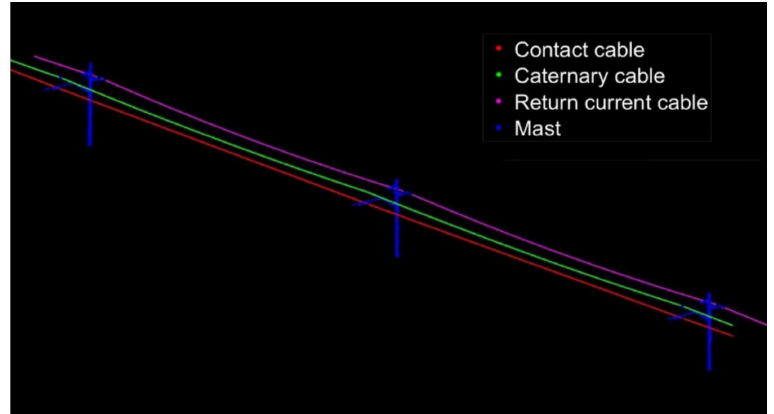
Figure 19. The result of 100 m OCS point cloud classification by TerraSolid. After statistics, the values of TP , TN , FP , and FN are calculated, and then the cor- responding accuracy indicators are calculated by the above four accuracy evaluation parameter formulas. The indicators are shown in Tables 5 and